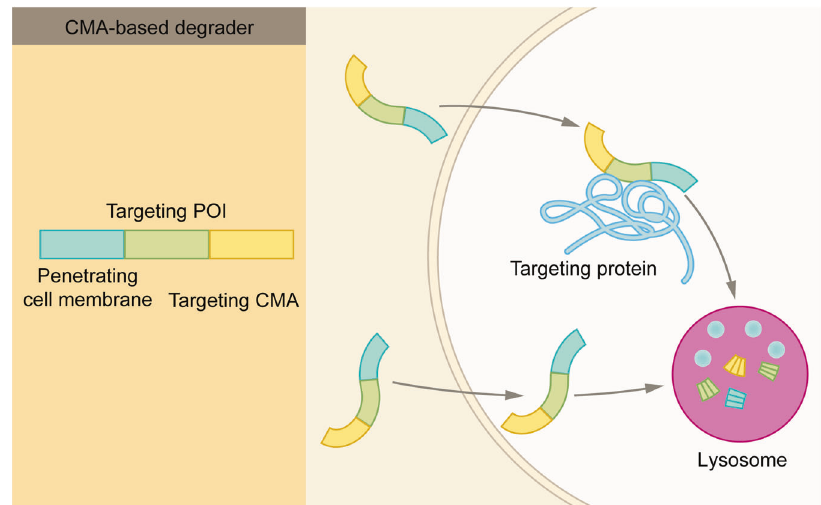
Fig. 12 Schematic representation of CMA-based degrader. CMA-based degrader consists of three modules: a CMA-targeting module, a cell- penetrating peptide, and a POI-targeting module. After the CMA-based degrader entering the cell, it binds the POI and induces chaperone- mediated